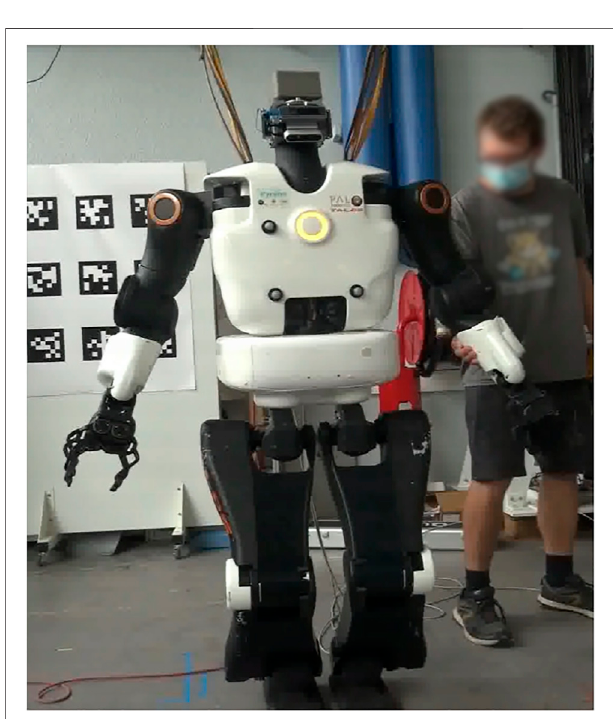
FIGURE 13 | Successful experiment using torque control for a postural task.